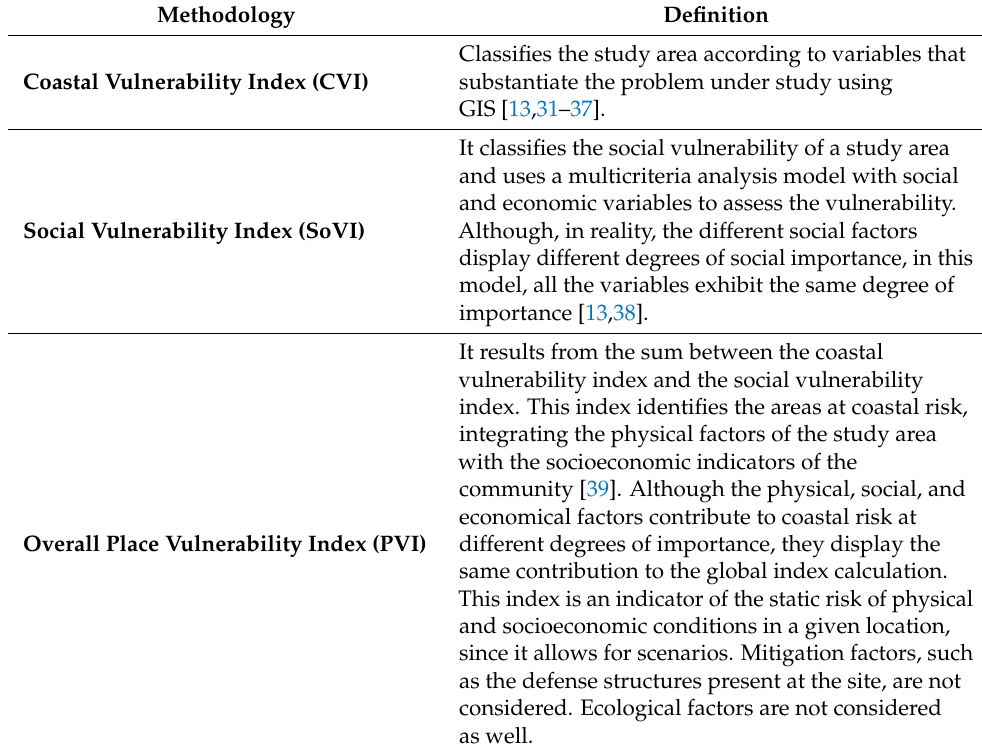
Table 1. Multicriteria analysis methods using